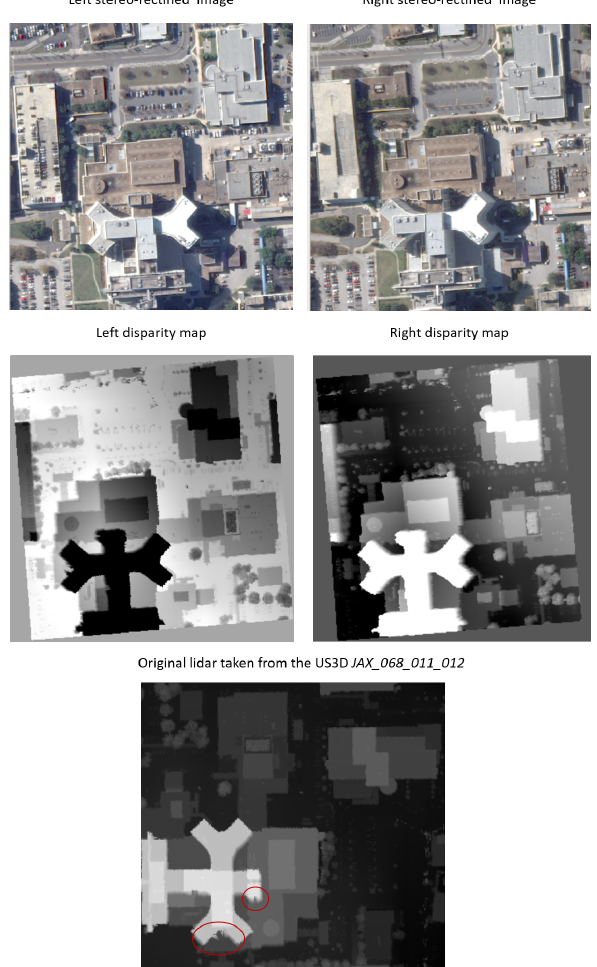
Figure 3. Top 4 images: Outputs of our ground truth pipeline produced from the US3D JAX 068 011 012. Bottom: input lidar raster with a 50cm resolution. It shows our disparity maps dependance on the input lidar raster accuracy (cf red circles added on the lidar, and corresponding areas in the disparity maps); and illustrates the time discrepancy between the inputs (cf